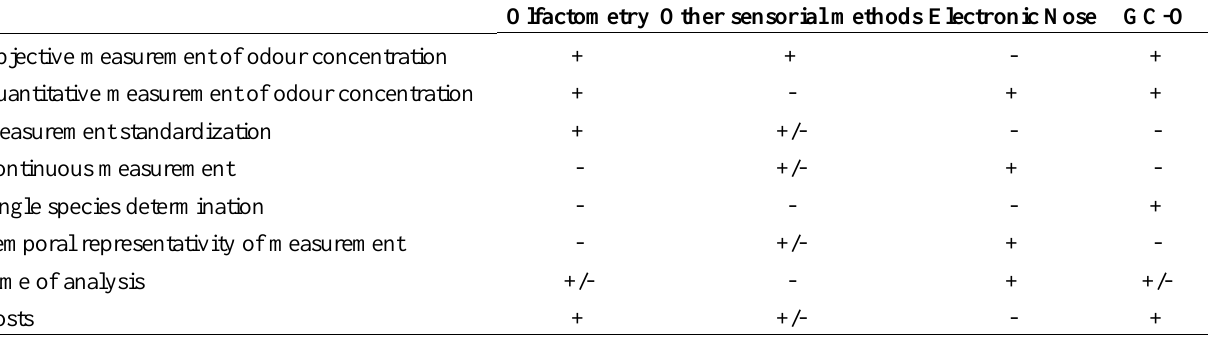
Table 3. Characteristics of odour measurement